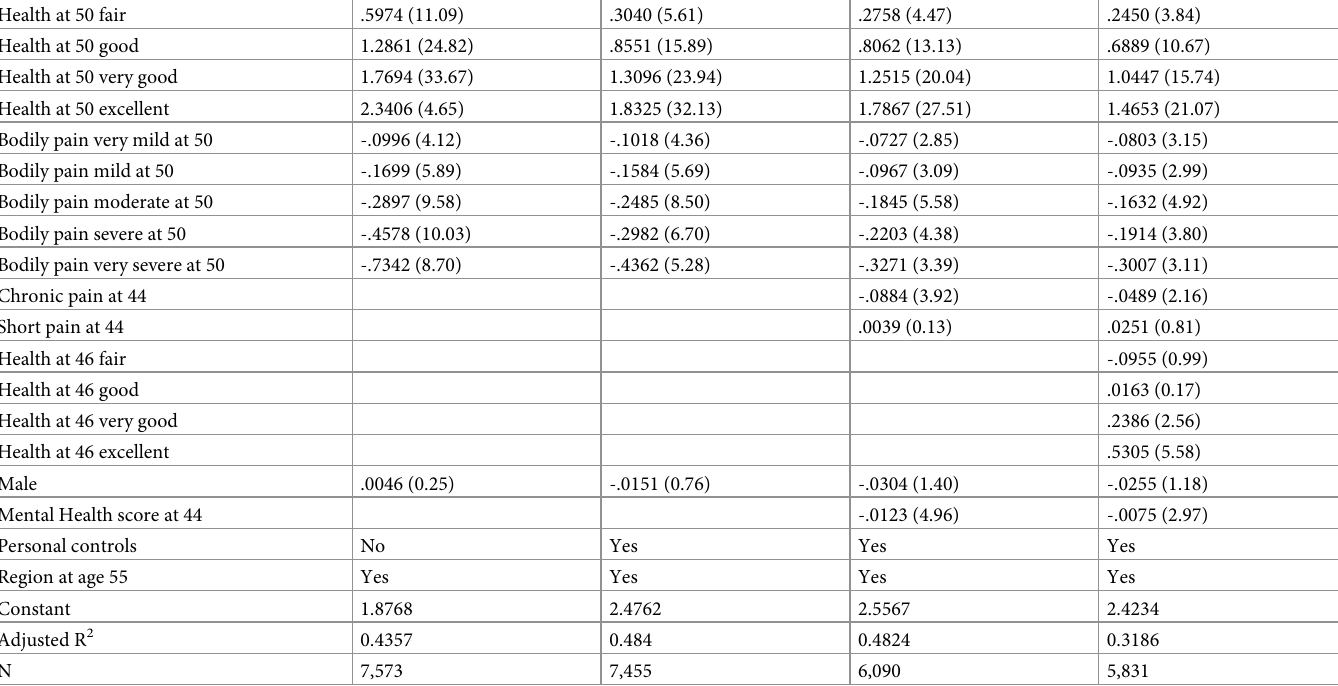
Table 13. General health in NCDS9 at 55